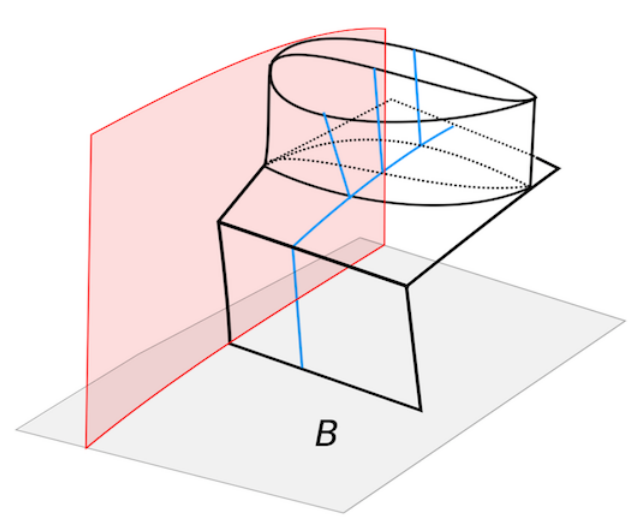
. We interpret G 2